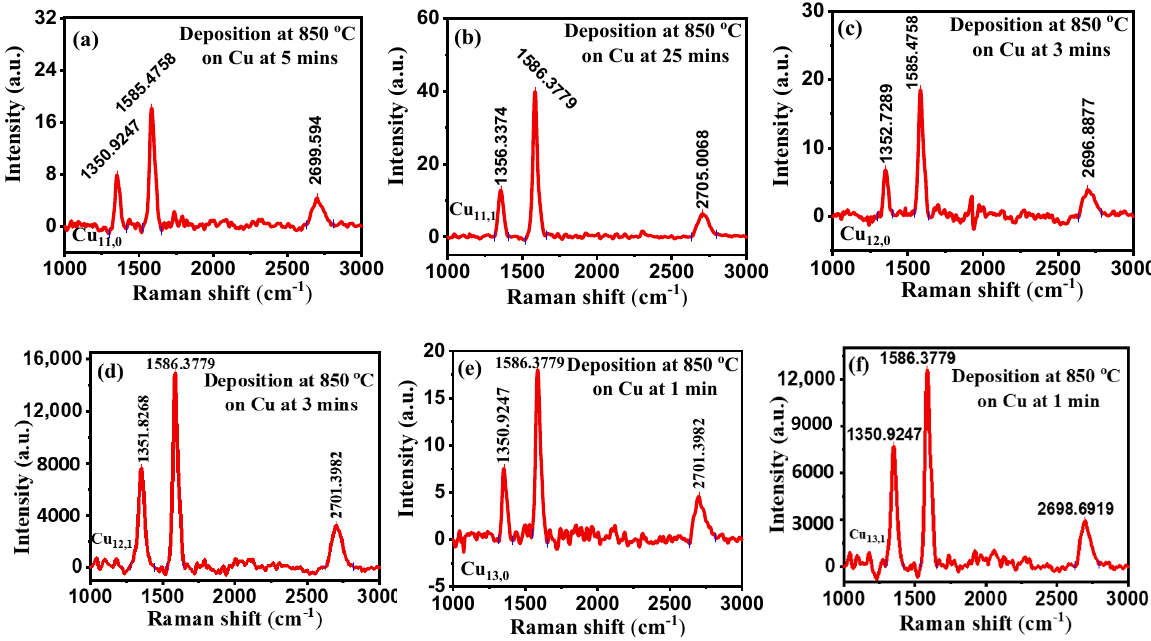
Figure 5. ( a – f ) Raman spectra at different deposition times with a constant CH 4 flow rate of 20 sccm and 850 °C deposition temperature.